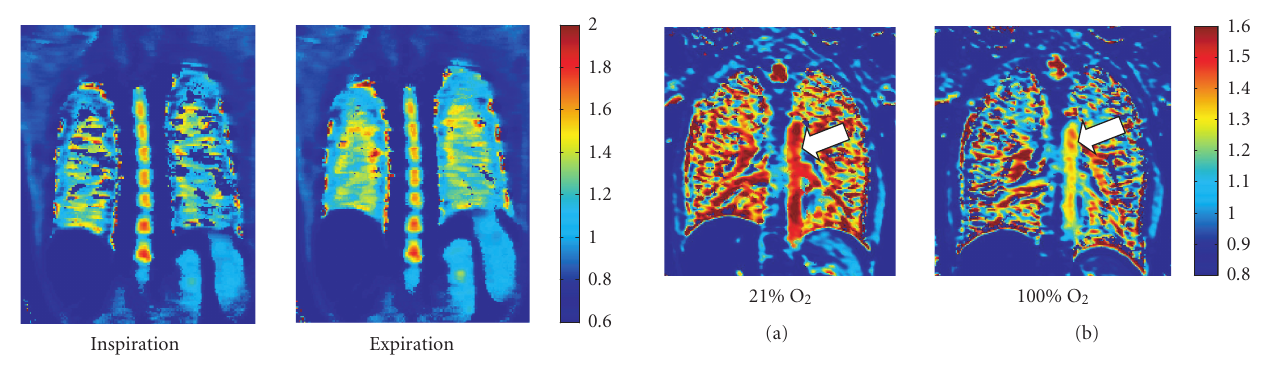
Figure 2: T1 map (seconds) of a healthy subject with inhalation of room air 21% oxygen (a), as well as inhalation of 100% oxygen (b). The increase of O 2 concentration shortens the T1 time of the lung parenchyma as well as the Aorta